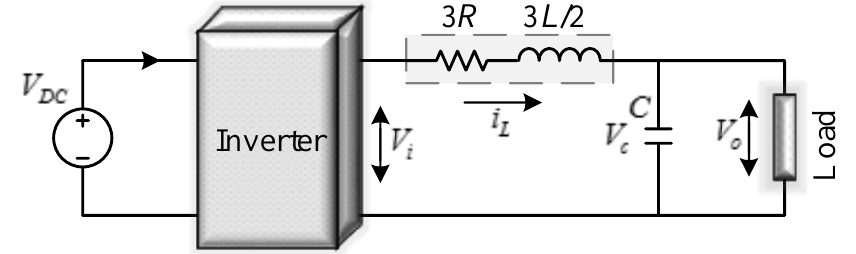
Figure 3. Per-phase representation of the four-leg inverter.